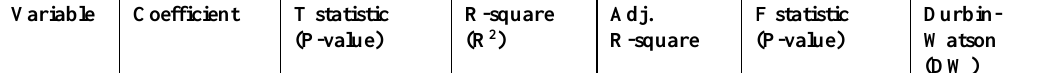
Table 4: Cross-section fixed effect panel single regression model to examine the RIC of EVA and profitability ratios with